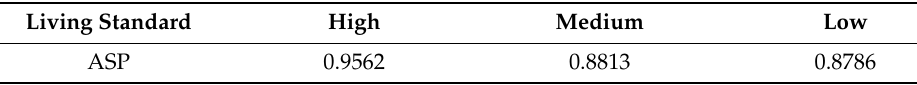
Table 3. Satisfaction scores in different living standards.